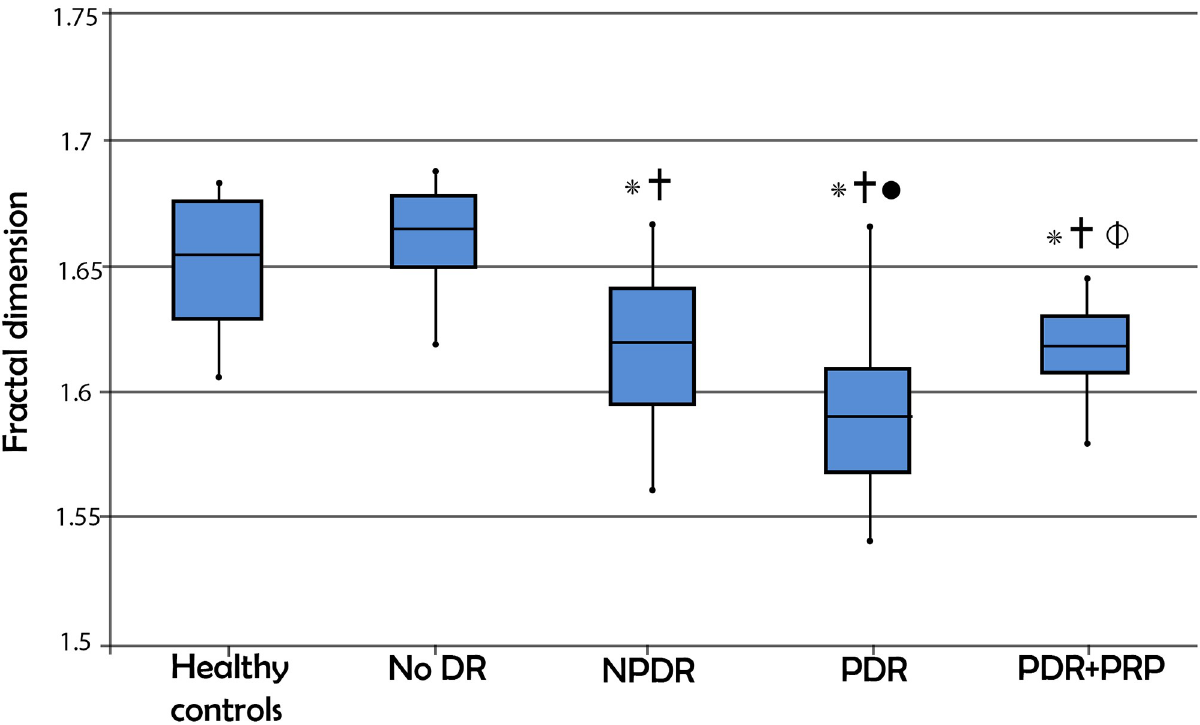
Fig 3. Box plot representation of the fractal dimension results in the 5 study groups. No DR: No diabetic retinopathy, NPDR: Non-proliferative diabetic retinopathy, PDR: Proliferative diabetic retinopathy, PRP: Panretinal photocoagulation, PDR+PRP: Proliferative diabetic retinopathy receiving panretinal photocoagulation. (p < 0.05, � significant vs Healthy controls,†significant vs no clinical DR, ● = significant vs NPDR, ɸ significant vs PDR).